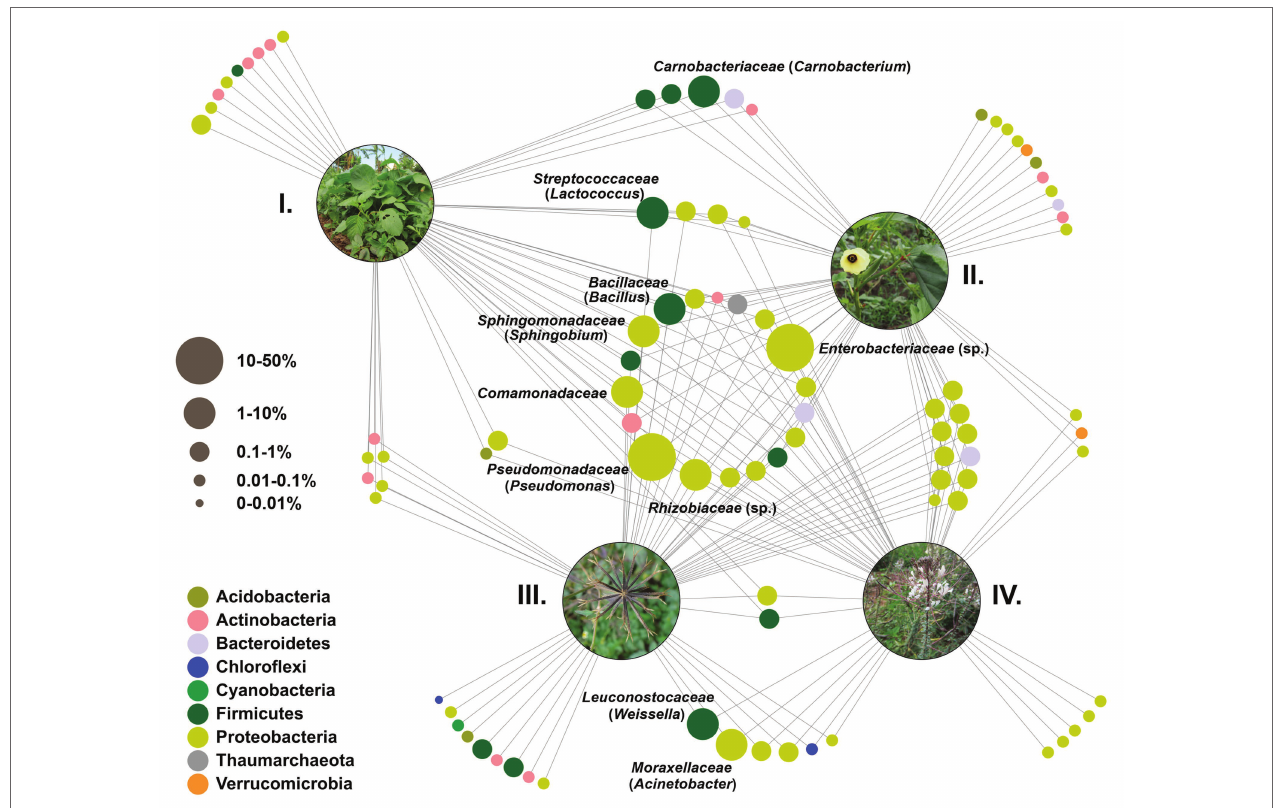
FIGURE 5 | Feature network based on taxonomic analysis at the genus level. Each node represents a family of the core microbiome and is colored according to its phylum. If families were only represented by one genus within the core microbiome, the corresponding genus is added in brackets. Cross-linked nodes express families shared between the plants blackjack, nightshade, okra, and spiderwisp. (I) Nightshade. (II) Okra. (III) Blackjack. (IV) Spiderwisp.